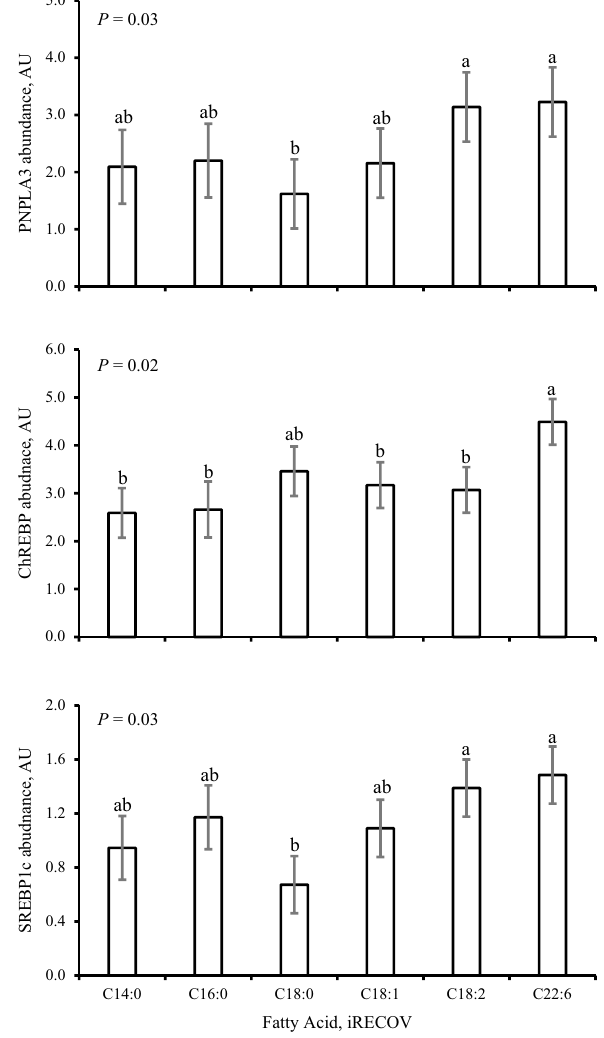
Figure 7. Protein abundance of patatin-like phospholipase domain-containing protein 3 (PNPLA3), carbohydrate response element binding protein (ChREBP), and sterol regulatory element-binding transcription factor 1c (SREBP1c) in response to individual fatty acids at the concentration physiologically found circulating in serum in dairy cows at 0.5 mM of circulating liver lipid clearing profile (iRECOV) in primary bovine hepatocytes. C14:0, C16:0, C18:0, C18:1 n-9, C18:2 n-6, and C22:6 n-3 are abbreviated as C14:0, C16:0, C18:0, C18:1, C18:2, and C22:6 in the figure for conciseness. Data is presented as least squares mean ± standard error of the means. Differences between individual fatty acids are indicated as alphabetic superscripts; when superscripts do not share the same letter, differences between the fatty acids were found ( P ≤